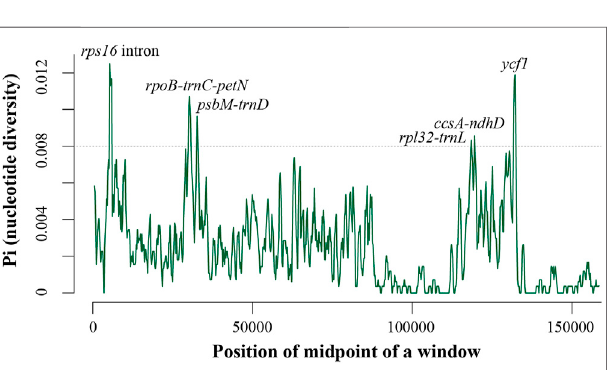
FIGURE 2 | Nucleotide diversity (Pi) in the complete plastomes of seven Aucuba plastomes. Sliding window analysis with a window length of 800 bp and a step size of 200